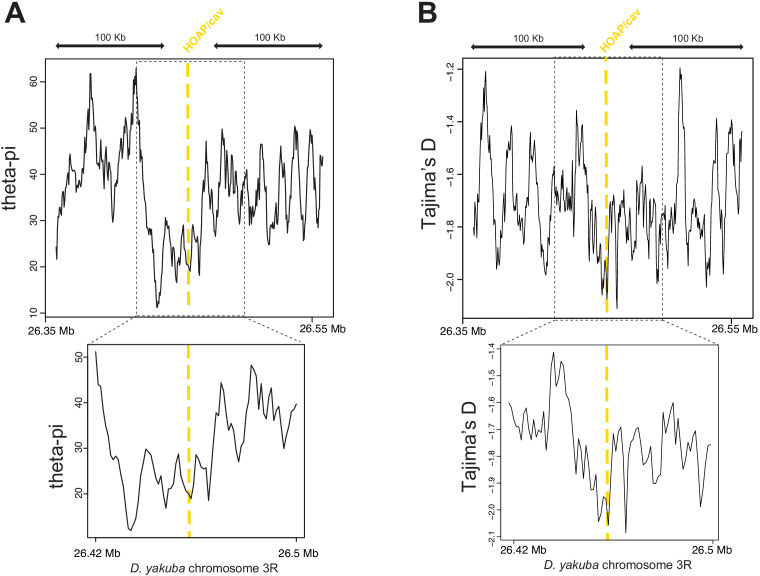
Valley of heterozygosity around the cav locus in D. yakuba.Parameter estimates from Rogers et al., 2015 centered around the cav locus. Theta-pi (A) and Tajima’s D (B) calculated from 20 D. yakuba alleles across 5kb windows sliding 500bp along 200kb (top) and 100kb (bottom).